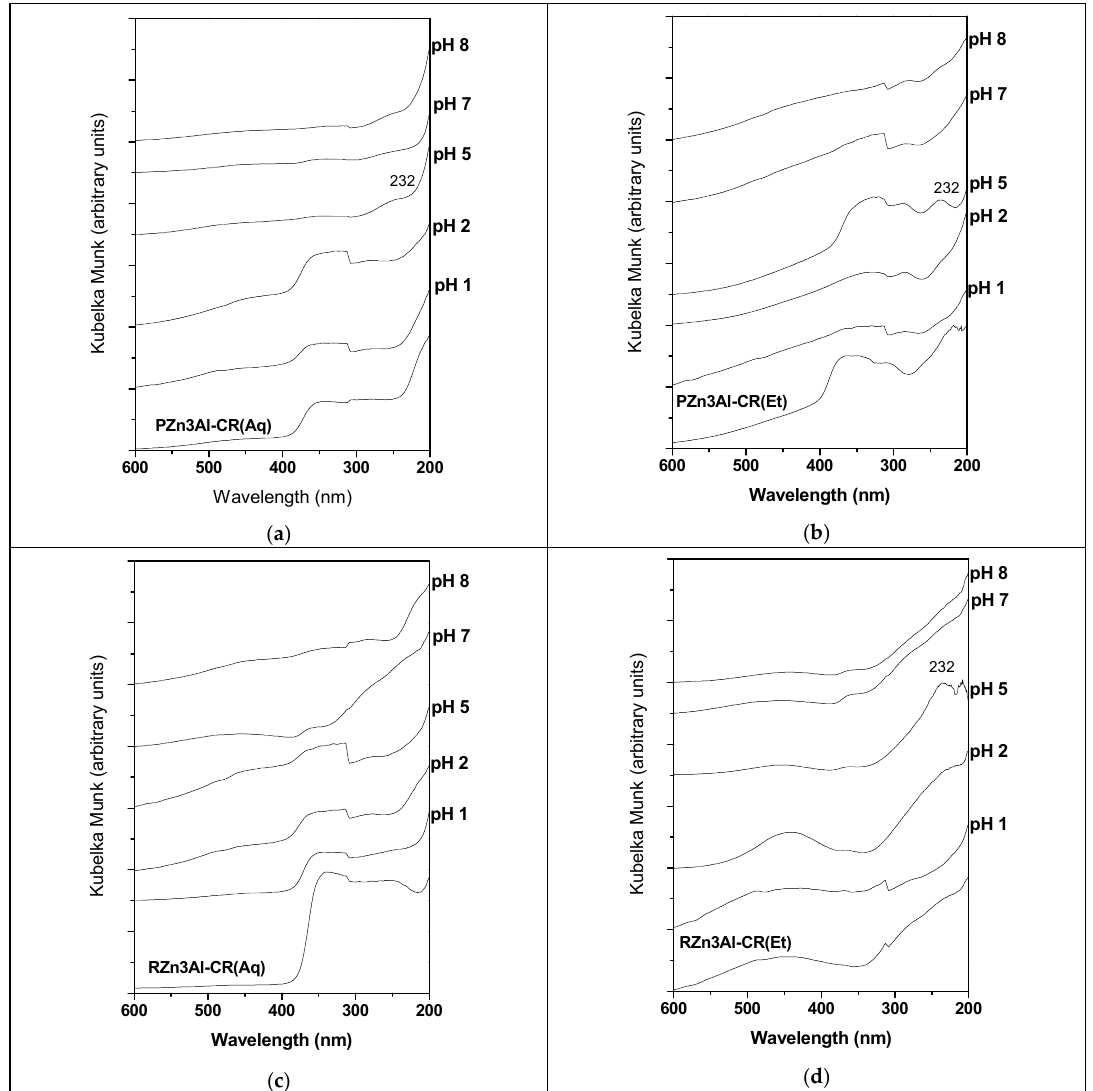
Figure 11. DR-UV–Vis spectra of the CR-containing samples after the CR-release tests at different pH values: ( a ) PZn3Al-CR(Aq); ( b ) RZn3Al-CR(Aq); ( c ) PZn3Al-CR(Et); ( d ) RZn3Al-CR(Et).